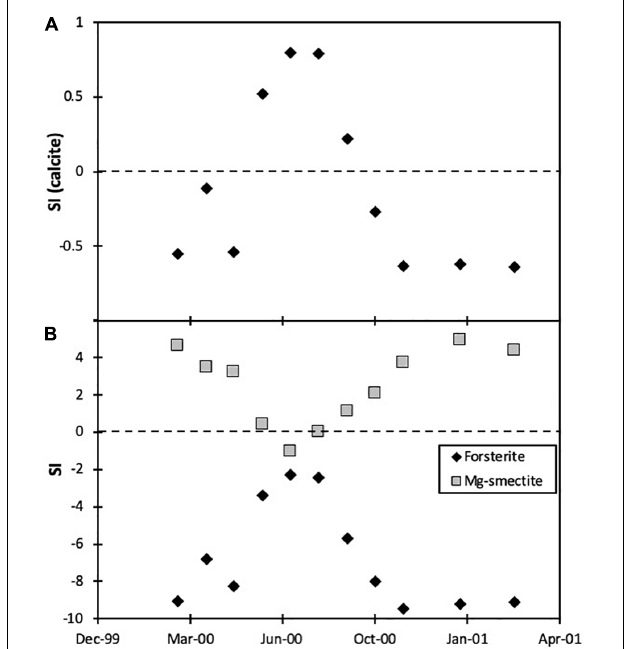
FIGURE 8 | Calcite (A) , forsterite, and smectite (B) mineral saturation indices for the Laxa River outflow time series.